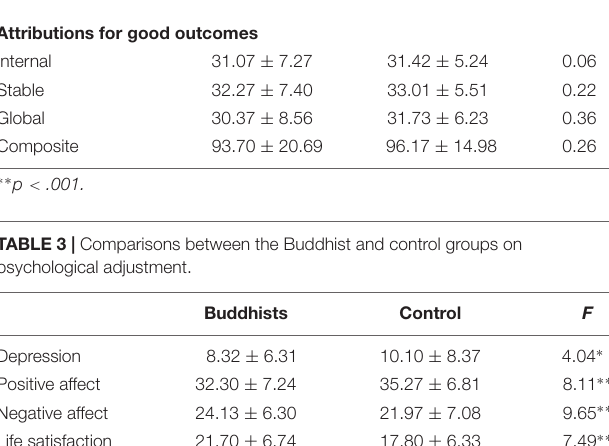
FIGURE 1 | Interaction effect of the depressive attributional style and Buddhist beliefs on